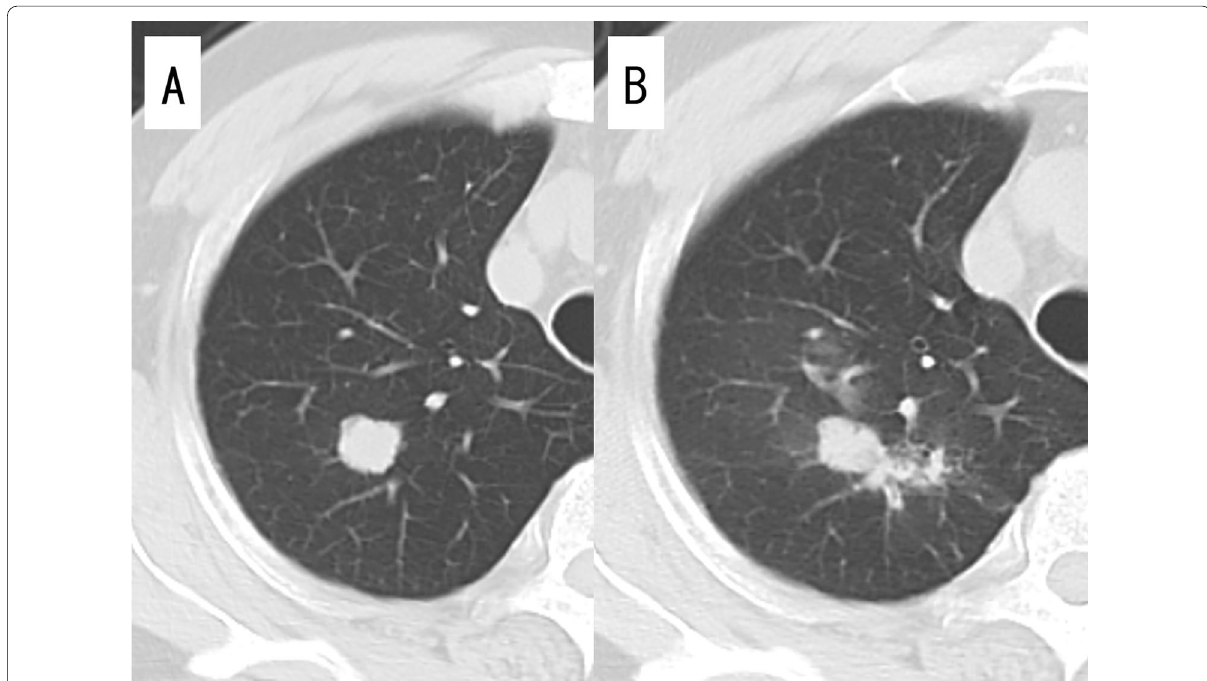
Fig. 1 Computed tomography (CT) images. A On initial examination, CT showing a nodule in the right upper lobe and B after massive hemoptysis on the eighth day after bronchoscopy. Scattered shadows, presumably blood, are confined to the upper